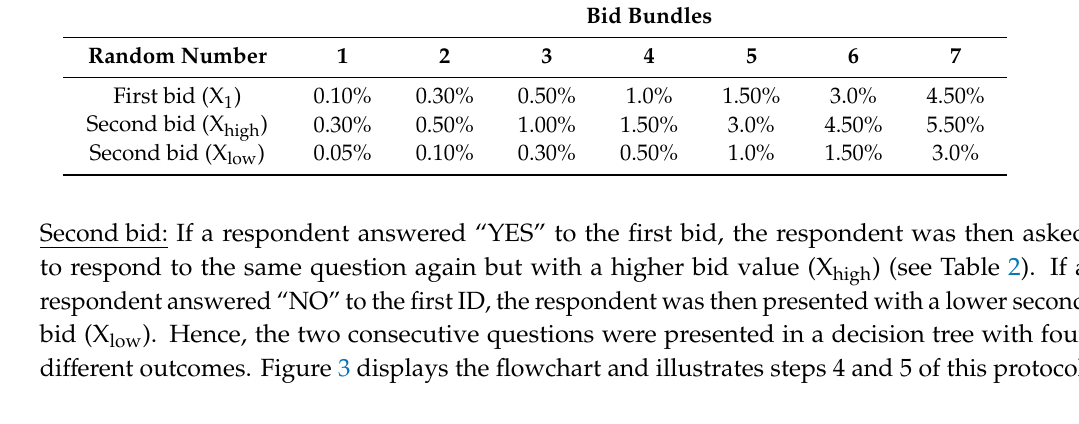
Table 2. Bid design for our Double Bounded Dichotomous Contingent Valuation (DBDCV) study. Bid Bundles